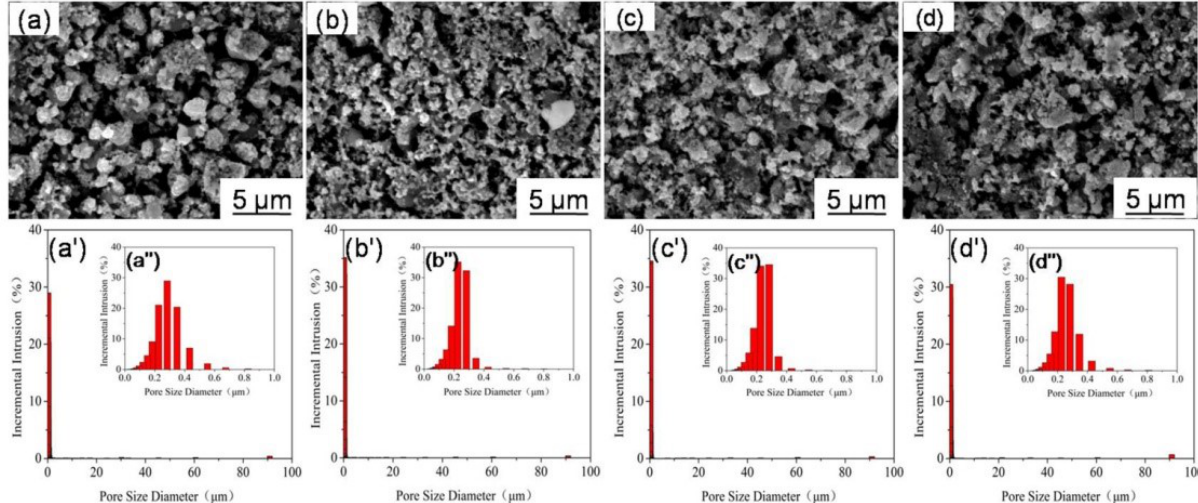
Figure 2: SEM morphologies and pore size distributions of sintered samples with different Mo contents: (a) 12 wt.%, (b) 14 wt.%, (c) 16 wt.%, (d) 18